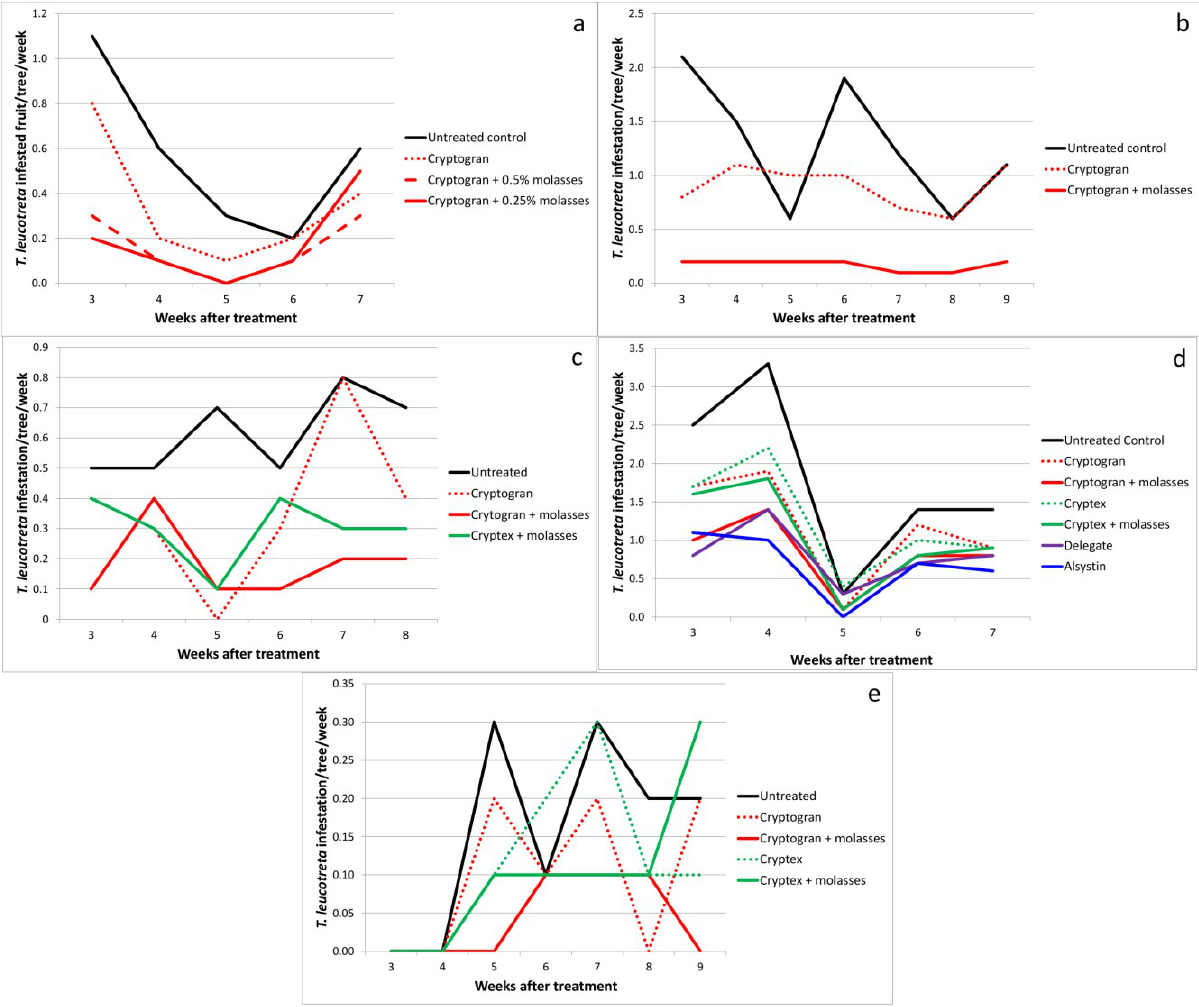
Figure 3. Thaumatotibia leucotreta -infested fruit per tree per week at ( a ) Bernol